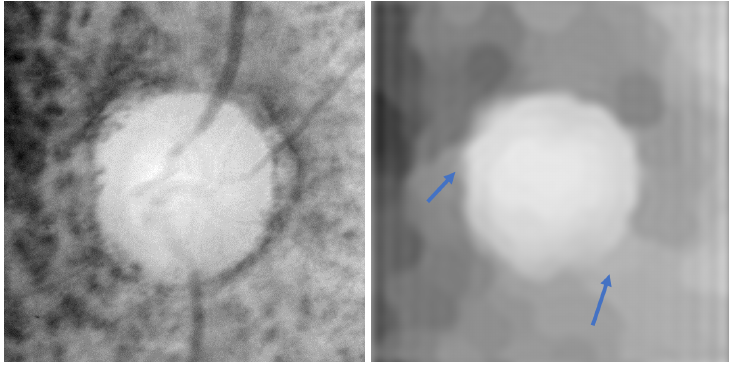
Figure 15. After blood-vessel and noise removal, bright noise (parts indicated by blue arrows) is generated, rendering the OD boundaries not obvious.